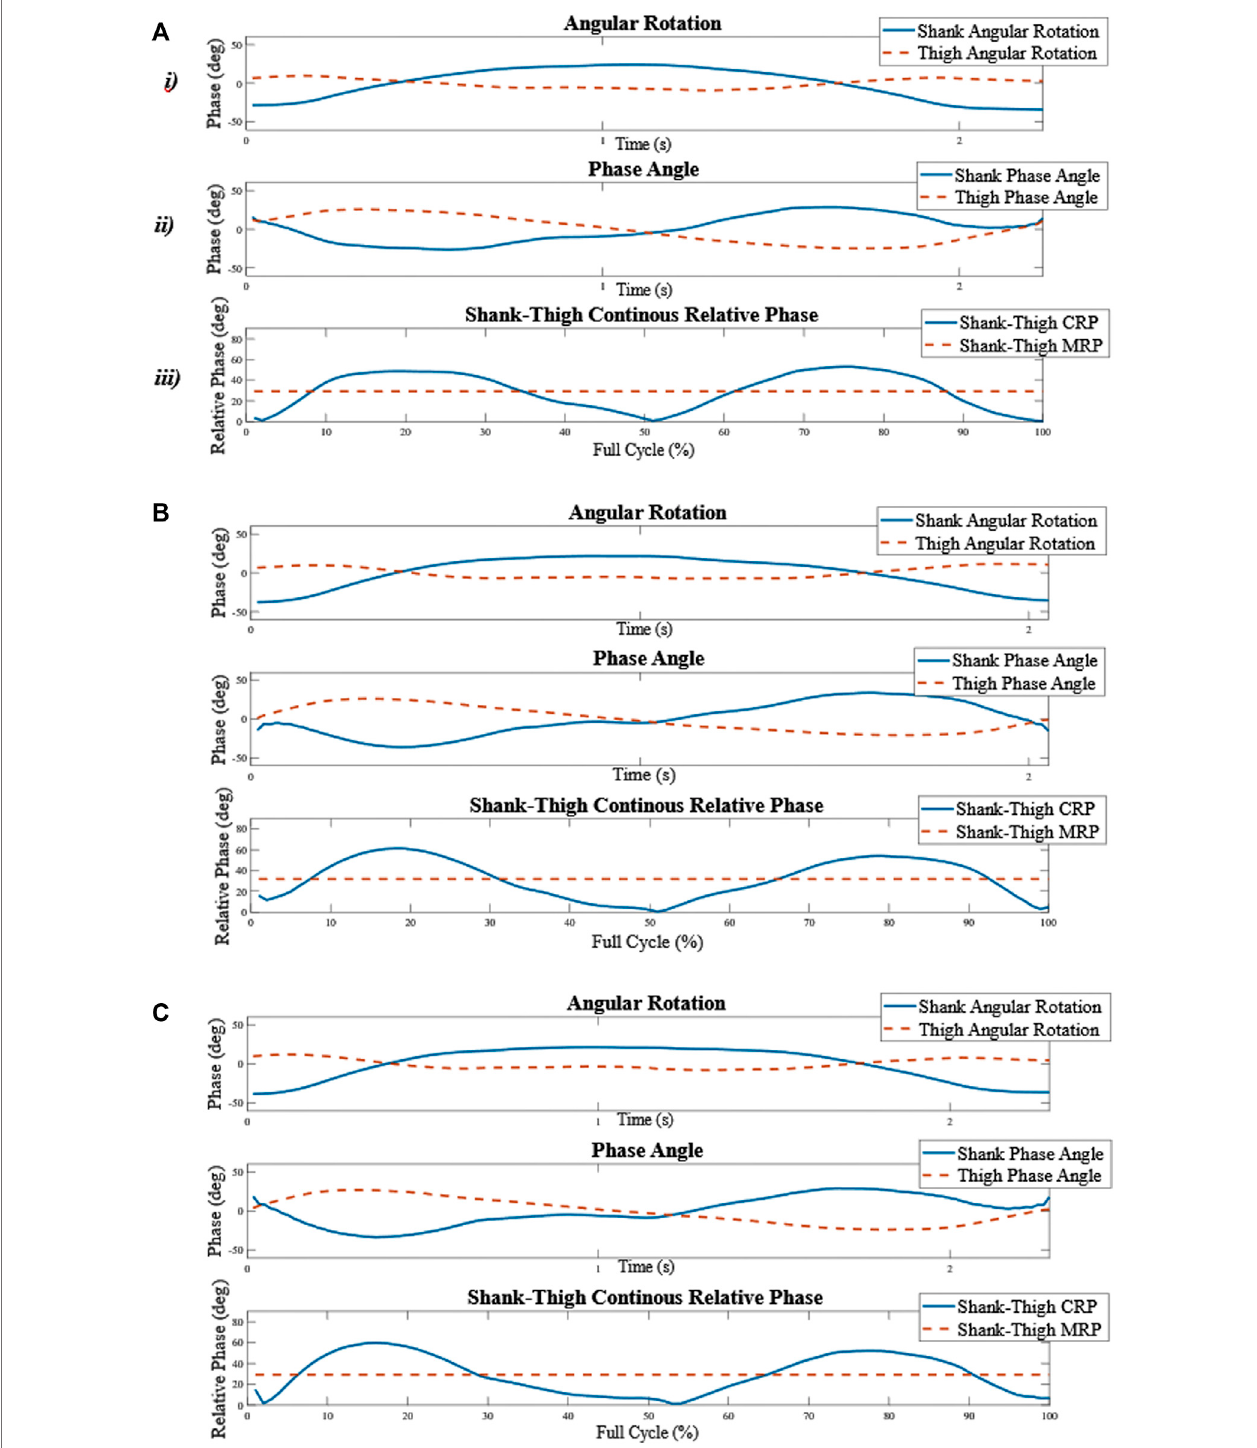
FIGURE2| Schematicoverviewofthecalculationoftheshank-thighcoordinationmeasures. (A) i )Theangularrotationoftherightthighandlowerleginthesagittal plane in one repetition oftheSUs. (A) ii )The right shank-thighcontinuousrelativephase (CRP) over the fullcycle of onerepetitionofthe SUs. (A) iii ) The meanof theCRP over the functional cycle is calculated and averaged for each repetition in each functionaltask for each participant and isreferred to asthe MRP. (B – C) The process was repeated for the second and the third repetitions. The standard deviation of the MRP over the three repetitions in every task is referred to as the linear coordination variability